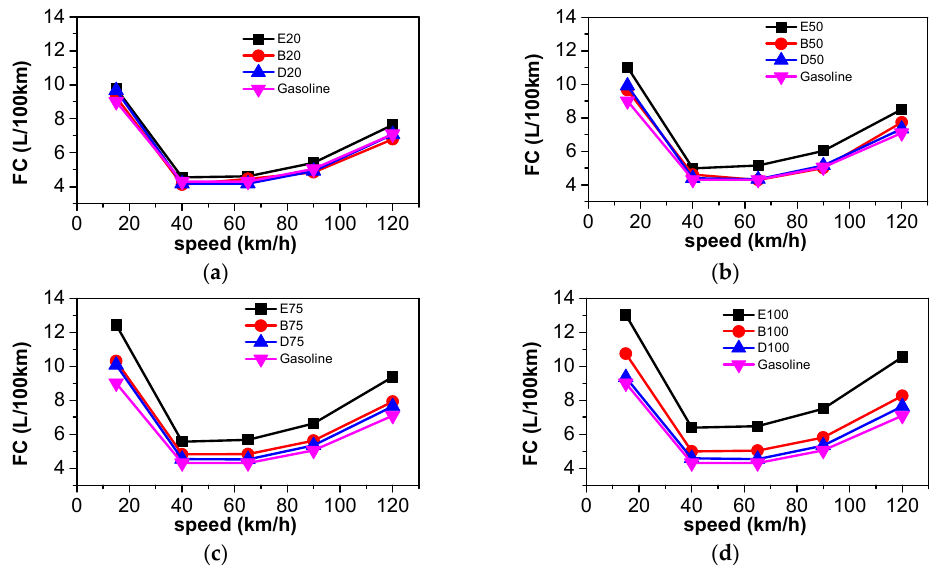
Figure 4. Comparison of volumetric fuel consumption (FC) of different fuels at different blending ratios: ( a ) 20% blending ratio; ( b ) 50% blending ratio; ( c ) 75% blending ratio; and ( d ) 100% blending ratio.